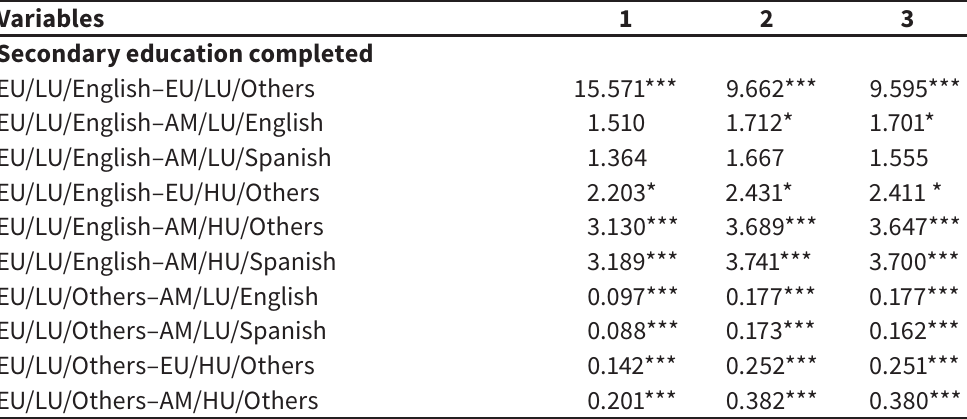
Location choice: destination countries classified by languages, URs, and